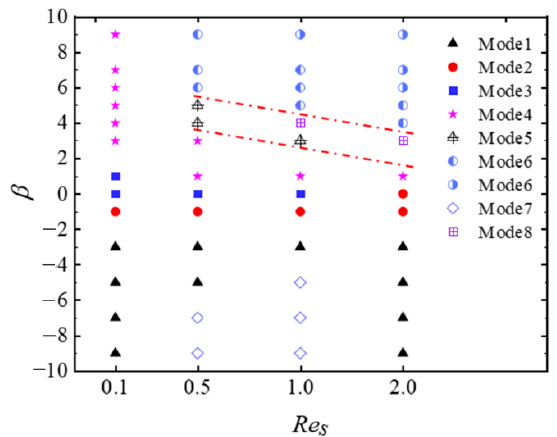
Figure 8. Motion mode of rod-shaped squirmers at different values of Re s and β ( s = d , i = 2). Mode 1: reverse swimming near the wall with periodic oscillation; Mode 2: close to the wall and moving forward; Mode 3: swimming forward away from the wall; Mode 4: positive swimming near the wall with periodic oscillation; Mode 5: octagonal motion; Mode 6: circular motion, where the left-hand solid circle indicates that the trajectory and rotation direction of the squirmer are both clockwise, and the right-hand solid circle indicates that the trajectory and rotation direction are both counterclockwise; Mode 7: reverse swimming away from the wall; Mode 8: swimming away from the wall with alternating clockwise and anticlockwise transformation. The red dotted line indicates the area of mode